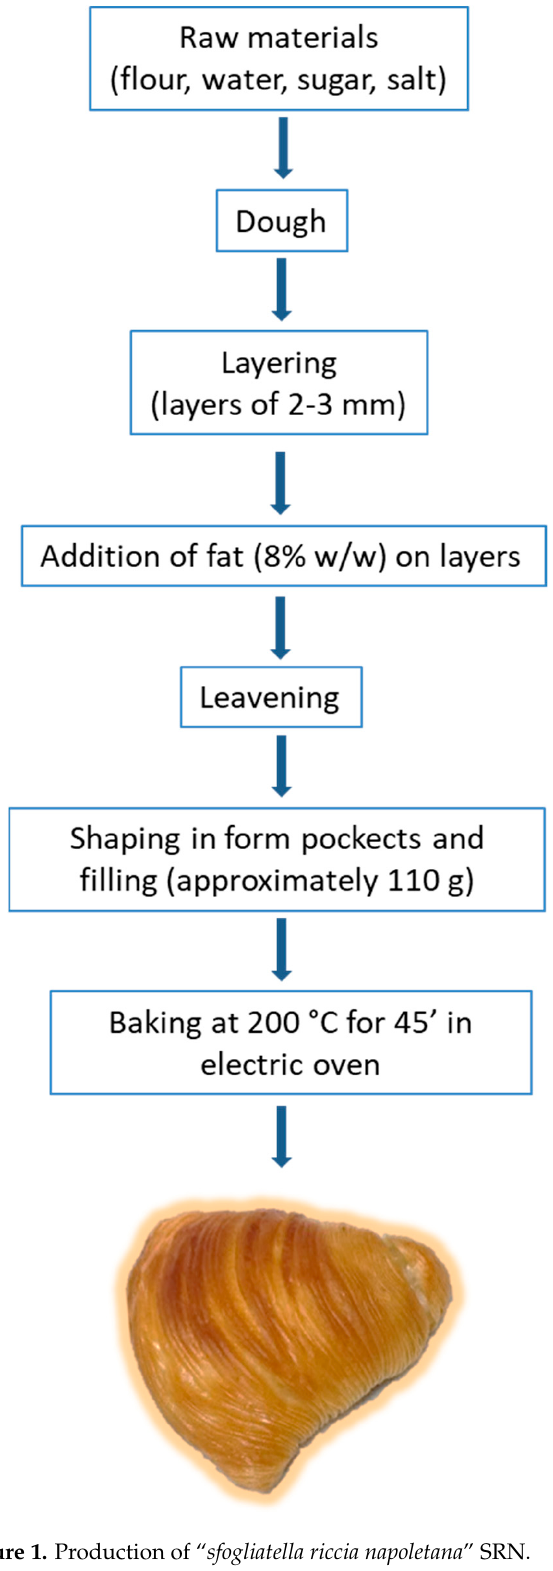
Figure 1. Production of “ sfogliatella riccia napoletana ” SRN.